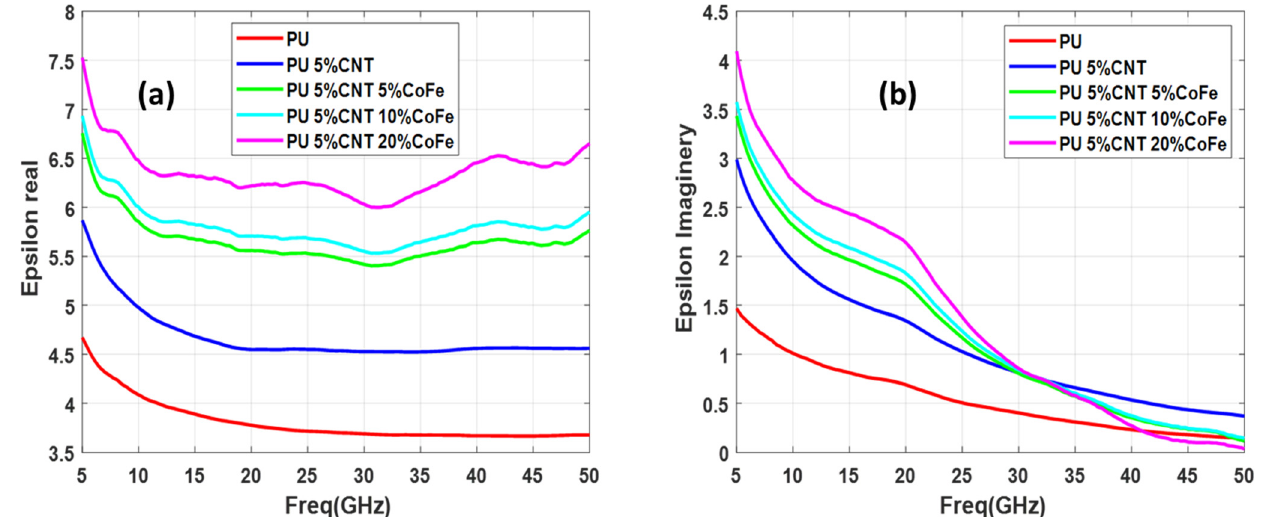
Figure 8. Permittivity of PU + 5%CNT with different concentrations of CoFe: ( a ) real part ( b ) imaginary part.